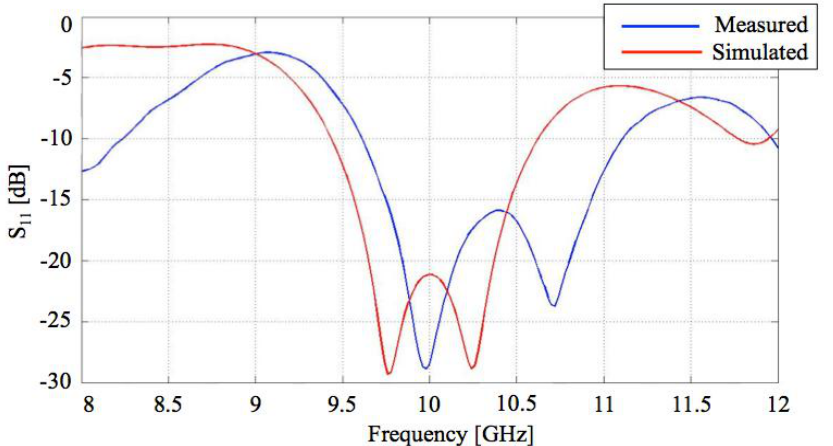
Figure 11. Reflection coefficient of receiving patch antenna: a comparison between calculated and measured values.